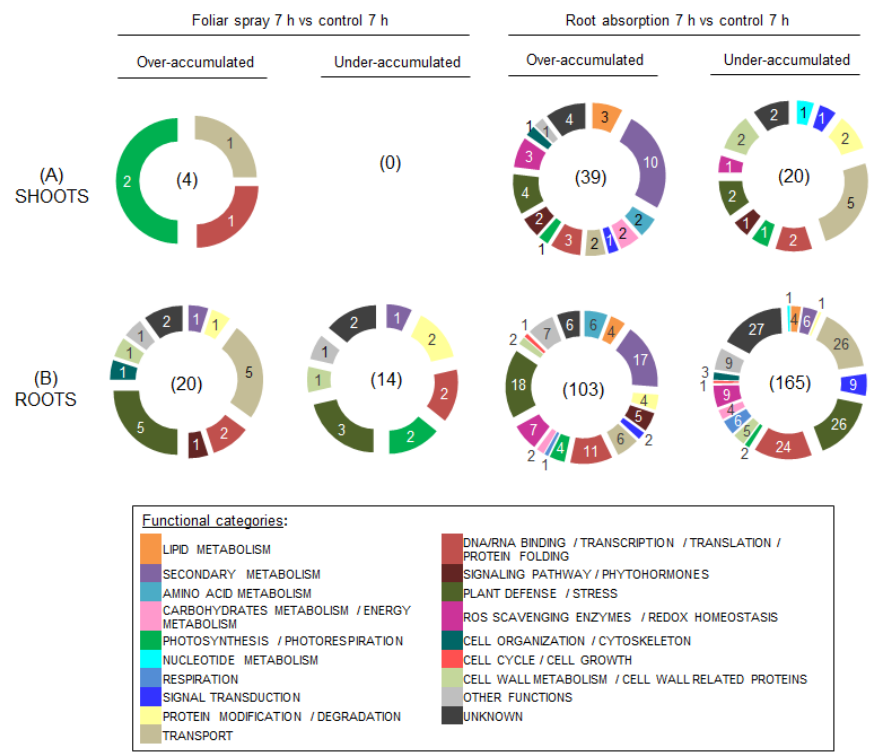
Figure 3. Functional classification of differentially accumulated proteins (DAPs) in shoots ( A ) and roots ( B ) of B. napus var. Darmor- bzh treated with RLs by foliar spray or root absorption versus control during 7 h. The protein families are assigned based on the information available in the Uniprot and Gene Ontology databases and reclassified according to the literature information. These experiments were performed on three biological replicates.